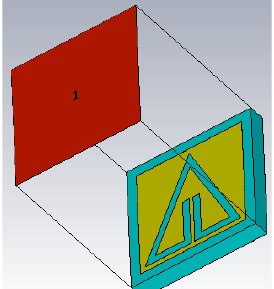
Fig .5. Waveguide simulation setup of proposed AMC unit cell.